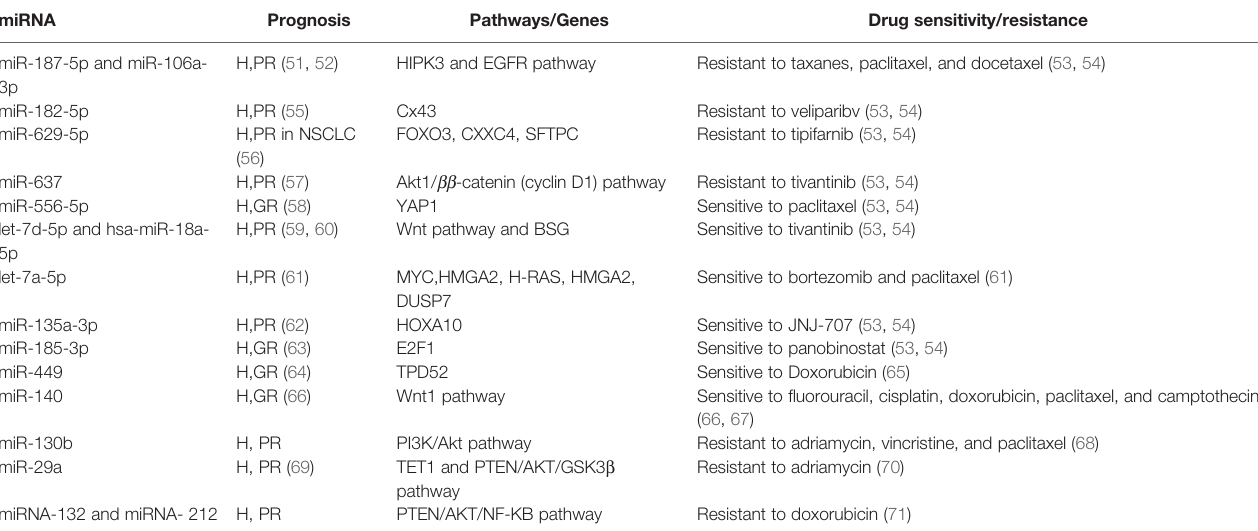
TABLE 1 | Summary of miRNAs associated with drug sensitivity and prognosis in breast